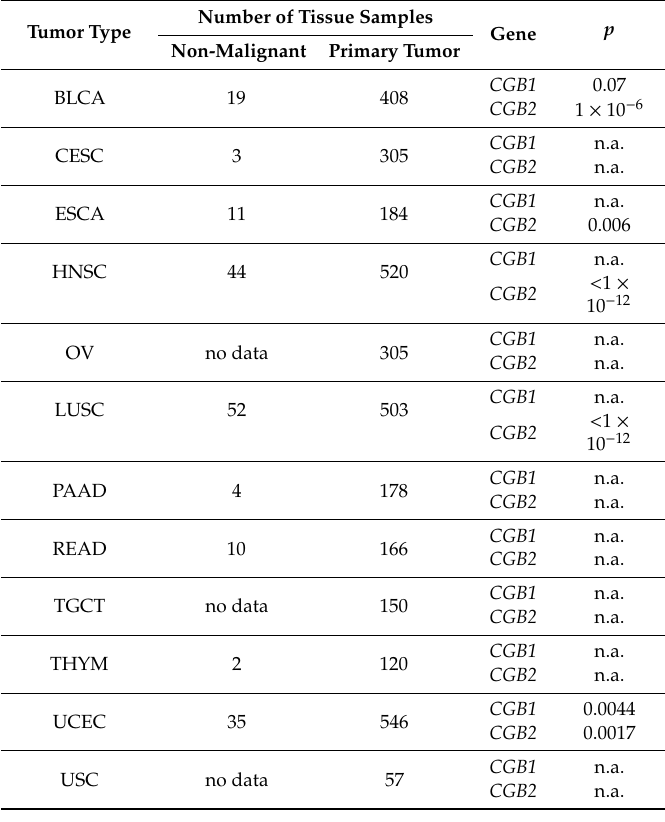
Table 4. Thedifferencein CGB1 and CGB2